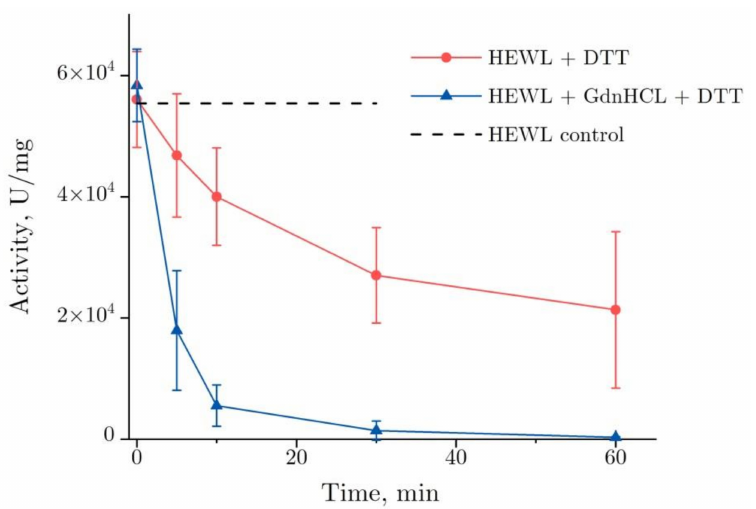
Figure 1. Changes in the enzymatic activity of lysozyme (4 mg/mL) in the course of its denaturation in GdnHCl and DTT (lower curve) and in DTT alone (upper curve) (pH = 8.0, 20 ◦ C). The data are presented as the mean and standard deviation calculated for three test runs. HEWL, hen egg white